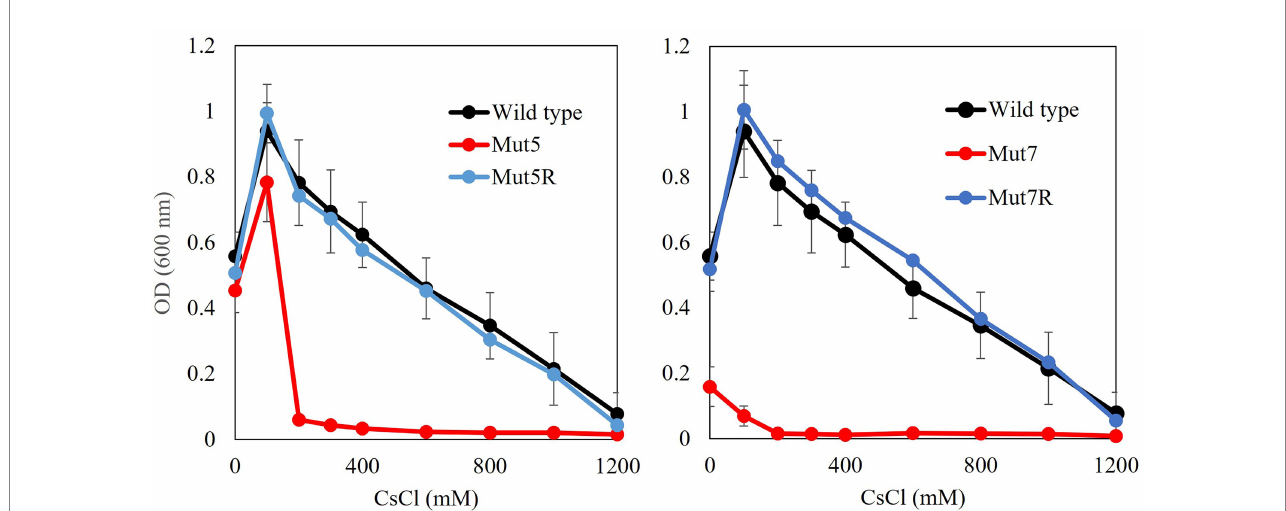
FIGURE 1 Cs + resistance growth tests on Cs + -sensitive mutants and Cs + -resistant revertants. Single colonies of each mutant were inoculated into 2 ml NC medium (pH 8.0) and shaken at 200 rpm and 30 ° C for 18 h. Ten microliters preculture was inoculated into 2 ml Tris medium (pH 8.0) containing 100–1,200 mM CsCl and shaken at 200 rpm and 30 ° C for 18 h. OD 600 was measured using spectrophotometry. Error bars show SD for three independent experiments.